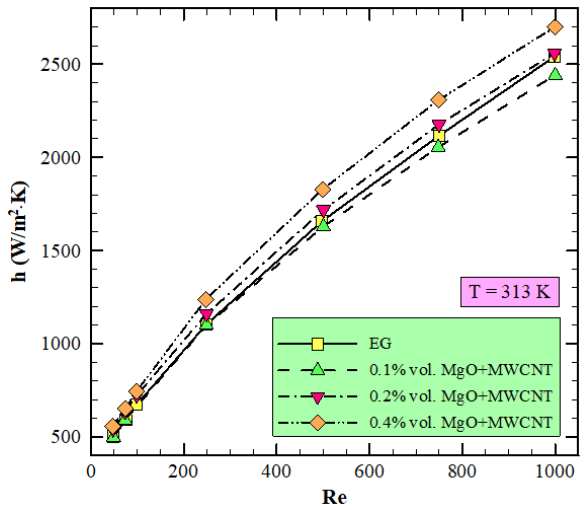
Figure 6. Effects of using HNF with different VF on HT coefficient for various Re and inlet temper- ature T = 313 K.